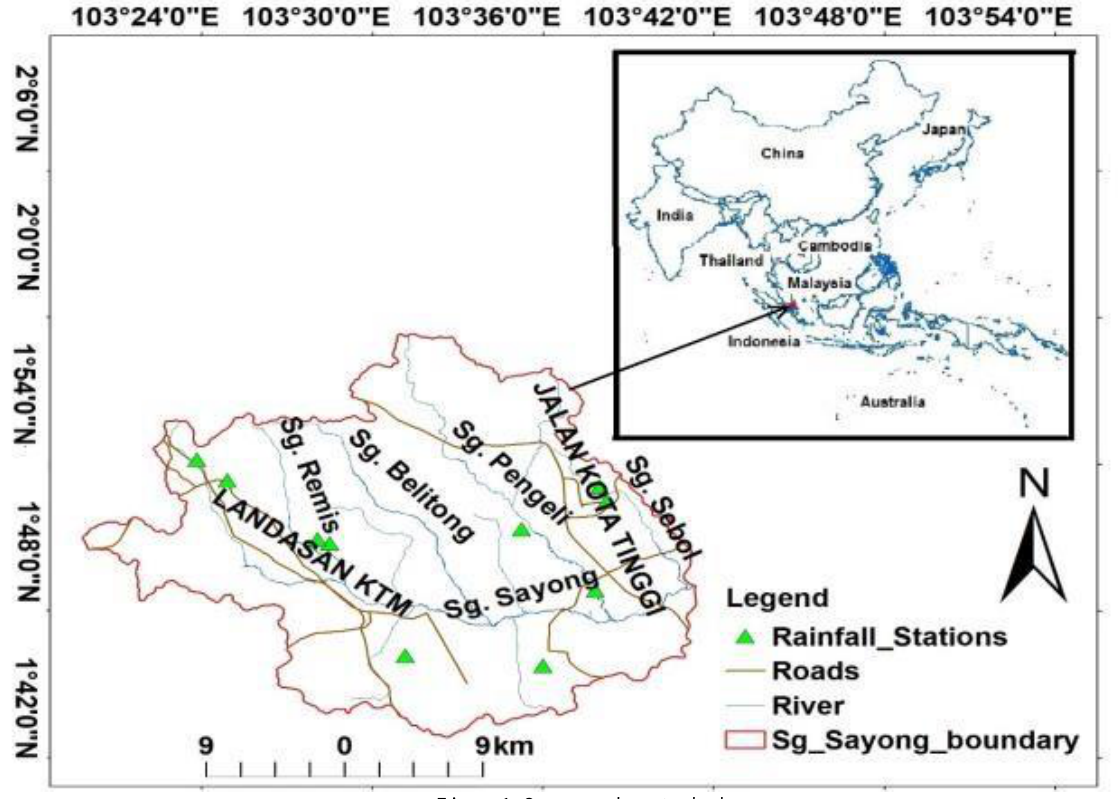
Figure 1. Sayong sub